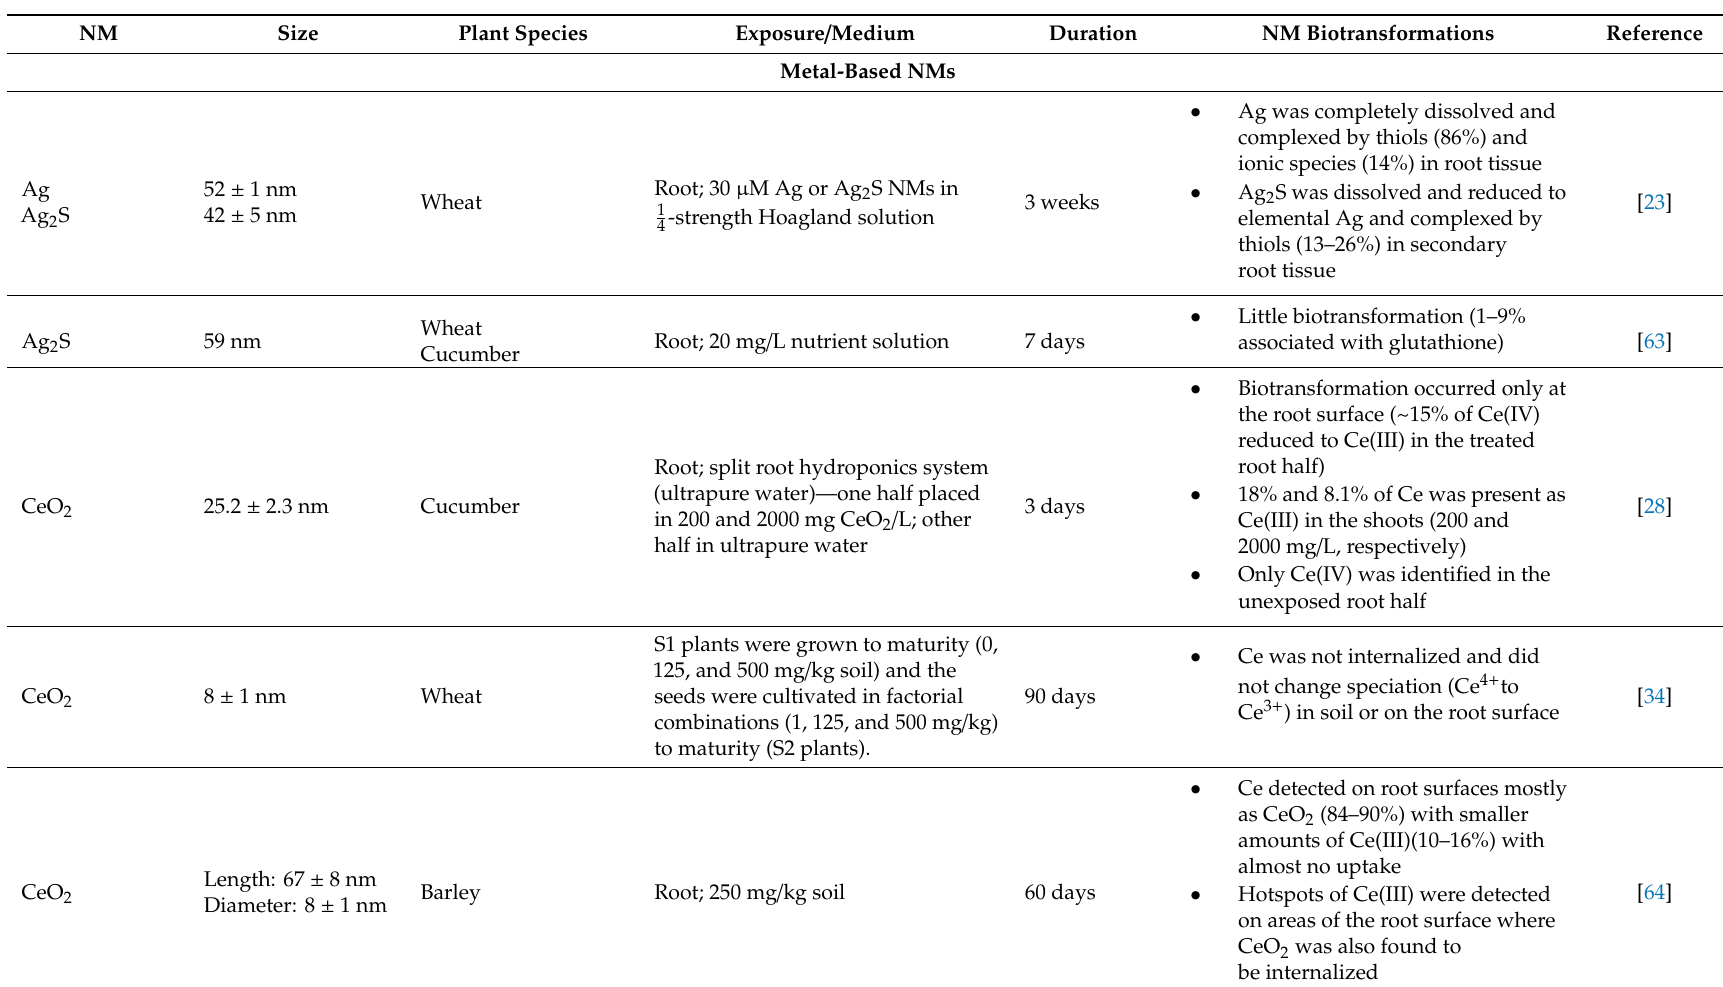
Table 3. Summaries of ENM biotransformation studies in plants from 2017 and